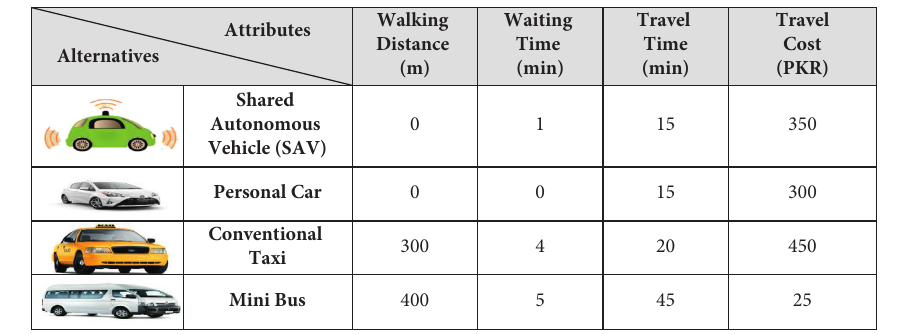
Figure 2: Example of a choice experiment in Lahore.